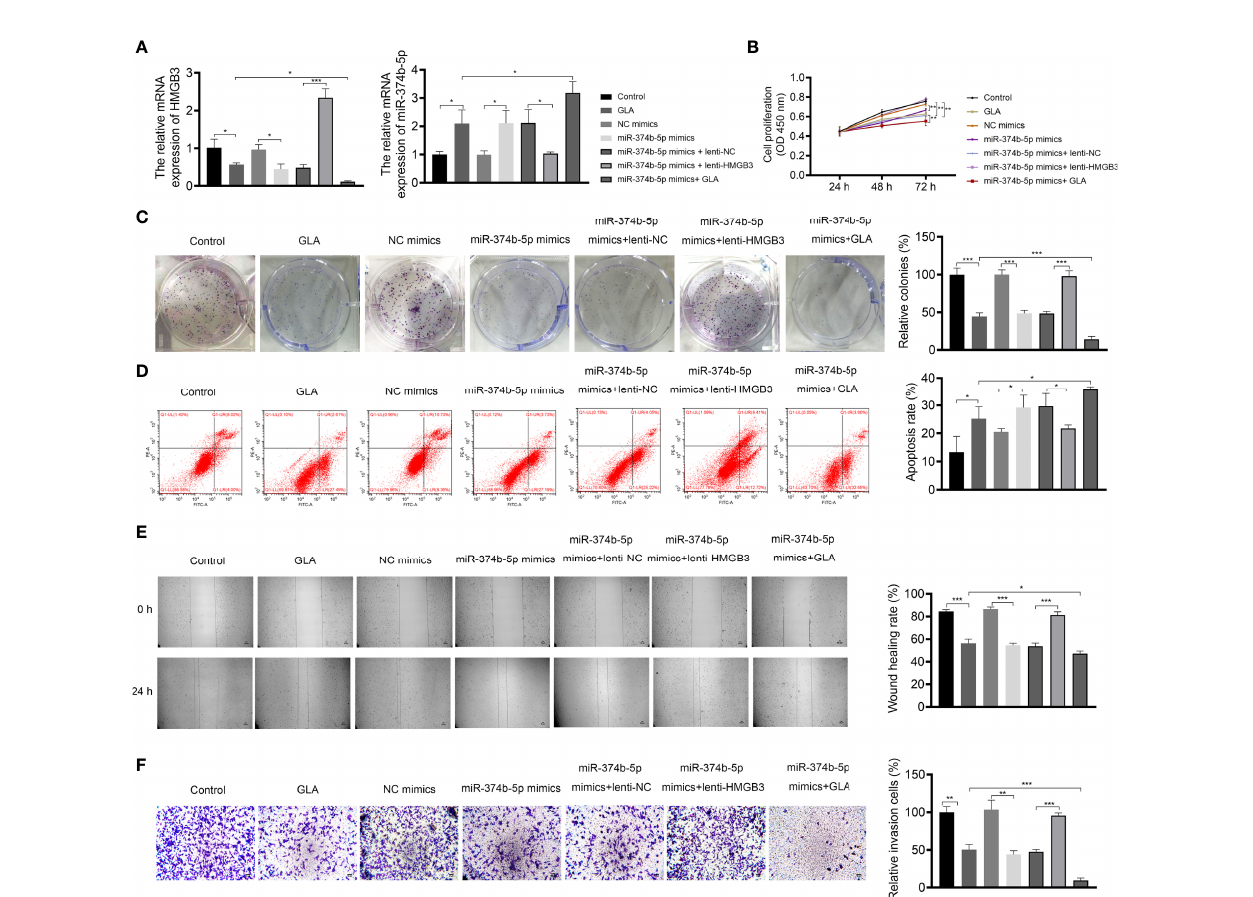
FIGURE 6 | GLA inhibited the malignant characteristics of EOC cells by affecting miR-374b-5p/HMGB3 axis. (A) The relative mRNA expression of miR-374b-5p and HMGB3 in SKOV3 cells was measured by qPCR. (B) The viability of SKOV3 cells was detected by CCK-8 assay. (C) The proliferation of SKOV3 cells was detected by colony formation assay. (D) The apoptosis of SKOV3 cells was detected by fl ow cytometry. (E) The migration of SKOV3 cells was detected by wound healing assay. (F) The invasion of SKOV3 cells was detected by the Transwell assay. Scale bar = 50 µm. SKOV3 cells were treated with GLA, miR-374b-5p mimics/NC mimics, and/or lenti-HMGB3/lenti-NC. * P < 0.05, ** P < 0.01, *** P <